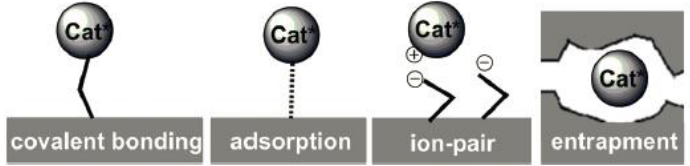
Figure 1. Schematic representation of four immobilization methods for the fabrication of metal- functionalized OMSs. Reproduced from Reference [14] with permission of The Royal Society of Chemistry.